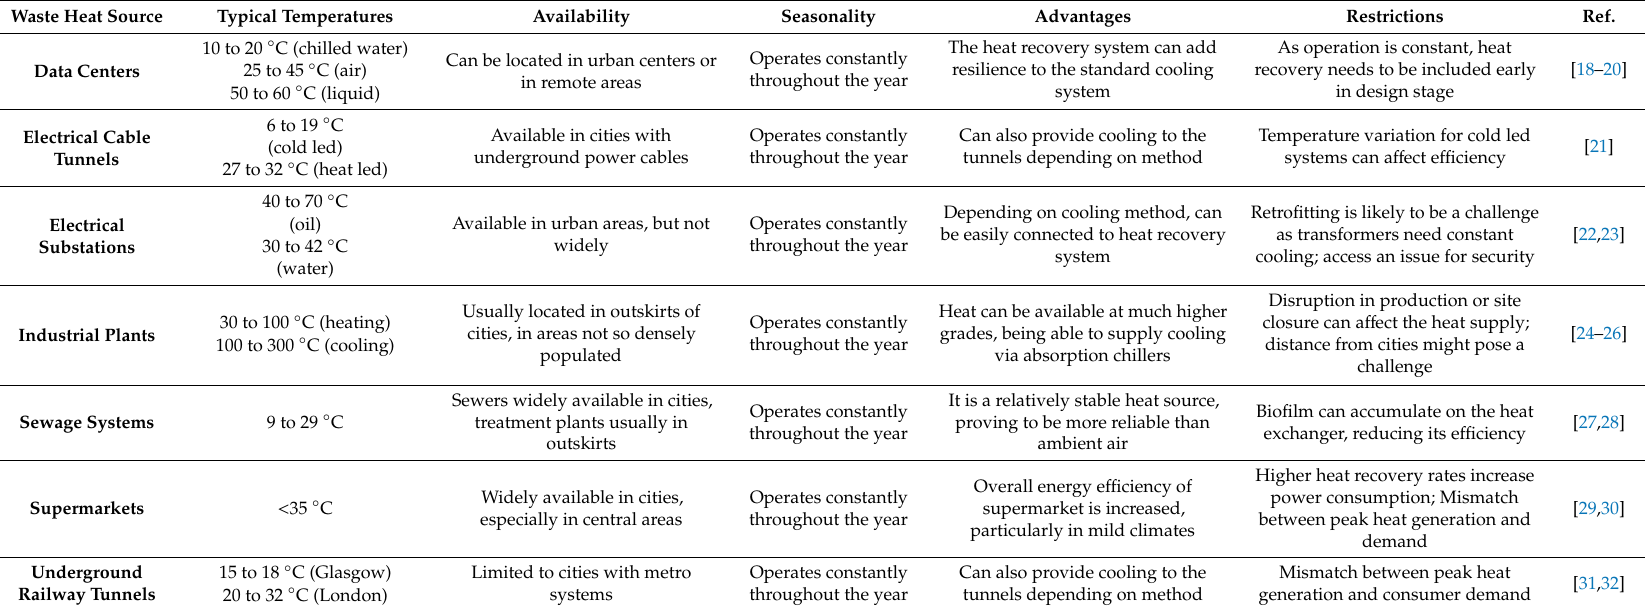
Table 1. The categorization of urban waste heat